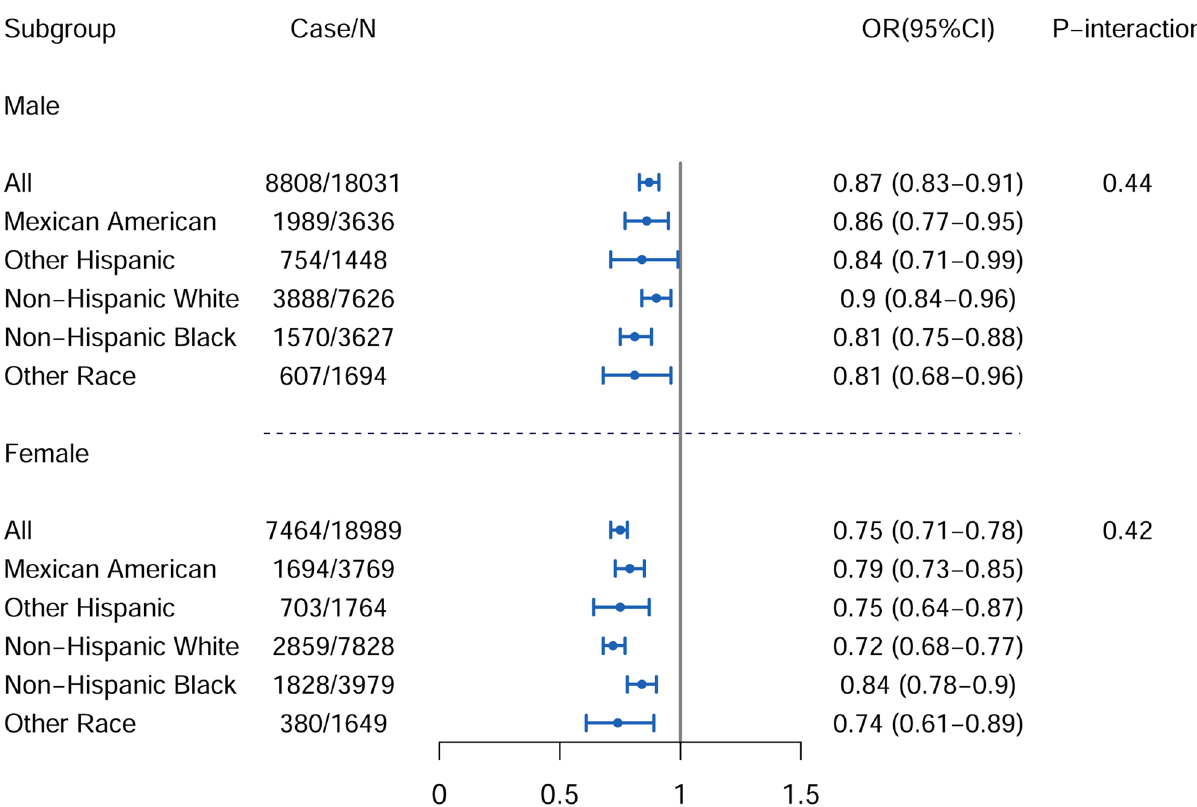
Figure 1. Race-stratified analysis of association between serum iron, with per SD increase, and presence of NAFLD. Adjusted for Model 3: age (years), race (Mexican American, other Hispanic, non-Hispanic white, non-Hispanic black, other race), marital status (married or cohabitation, widowed or separated, never married), education level (less than 12th grade, high school or equivalent, college graduate or above), family poverty income ratio, smoking status (never, ever, current), alcohol intake (drinkers/week), leisure activity (MET- min/day), total energy intake (kcal/day), healthy eating index-2015, lead (μg/dL), cadmium (nmol/L); MET metabolic equivalent, SD standard deviation, NAFLD nonalcoholic fatty liver disease. The figure was created by RStudio (Version 1.3.1056, URL: https:// www. rstud io.